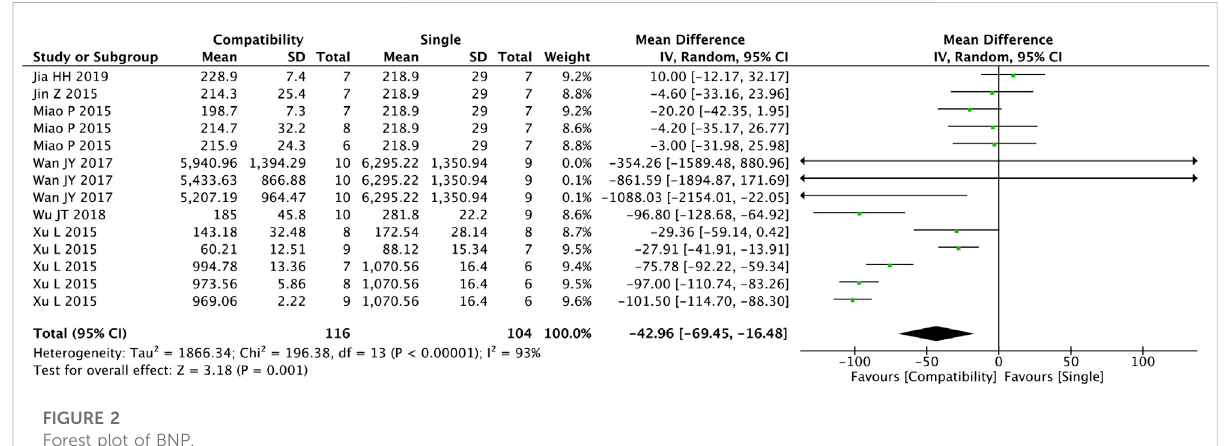
FIGURE 2 Forest plot of